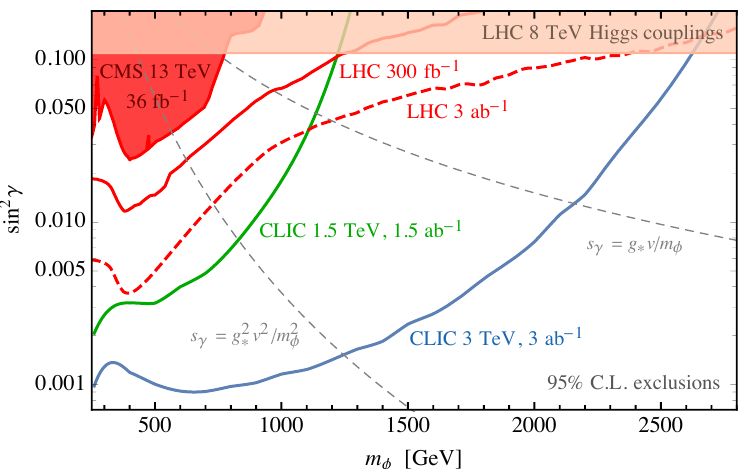
Figure 6. Exclusions at 95% C.L. in the plane ( m (cid:30) ; sin 2 (cid:13) ). The shaded regions are the present constraints from LHC direct searches for (cid:30) ! ZZ (red) and Higgs couplings measurements (pink). The reach at CLIC Stage II (green) and Stage III (blue) in (cid:30) ! hh (4 b ) is compared with the projections for LHC in (cid:30) ! ZZ with a luminosity of 300 fb (cid:0) 1 (solid red) and 3 ab (cid:0) 1 (dashed red). We have (cid:12)xed BR (cid:30) ! hh = BR (cid:30) ! ZZ = 25%. The dashed grey lines show two di(cid:11)erent scalings of s (cid:13) with m (cid:30) , as described in section 2.1 ( g (cid:3) = 1 in both cases).